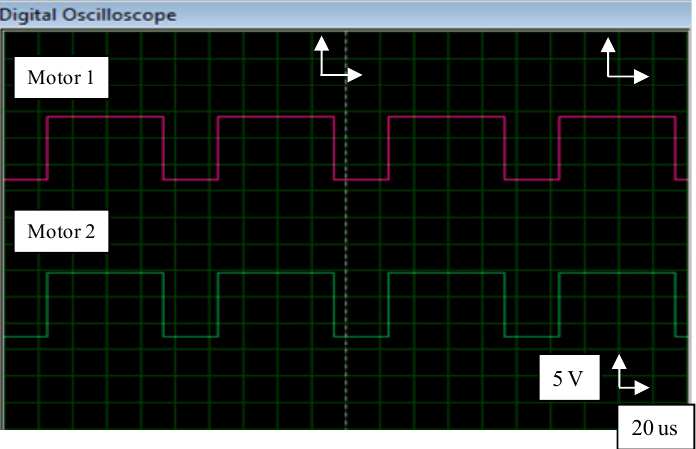
Figure 11. Terminal signals of the motor1 and motor 2.